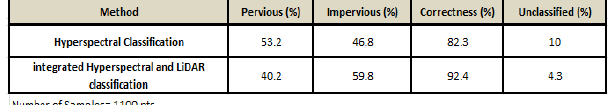
Table 1. Classification accuracy assessment results